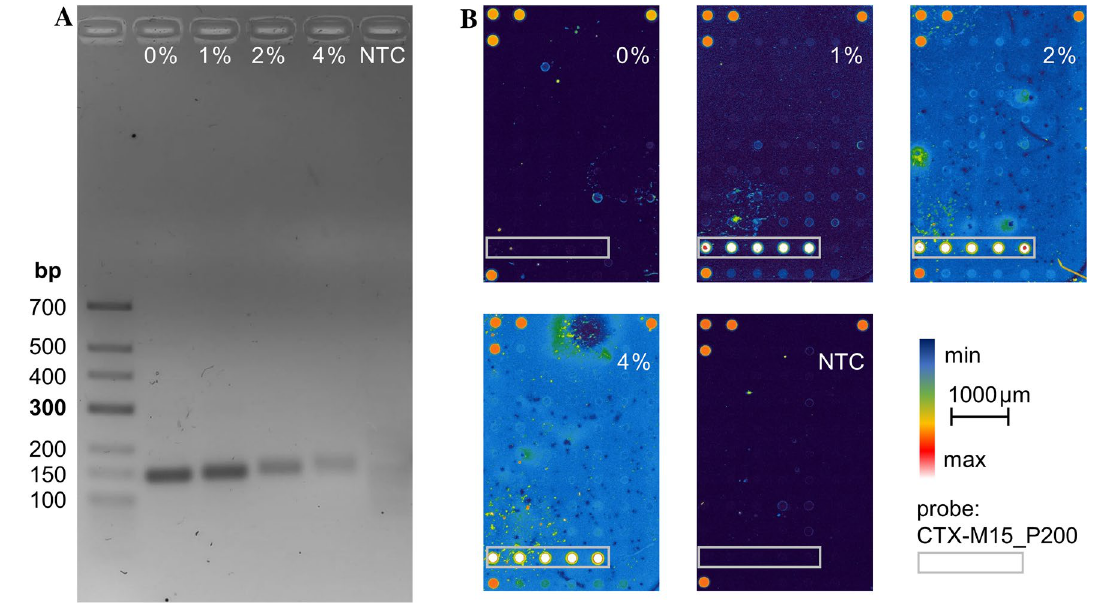
Figure 2. Determination of the suitable Cy5-dUTP amount. 40 min RPA (38 °C) was performed using the resistance gene bla CTX-M15 in E. coli genomic DNA samples as target. ( A ) Gel electrophoresis with purified amplicons after RPA with different Cy5-dUTP amounts compared to the unlabelled dTTP. (NTC: no template control). ( B ) Hybridization and microarray detection of the RPA products shown in ( A ). (grey box indicating the position of the bla CTX-M15 specific probe; pictures are false colour displayed, NTC: no template control; scan power 60% PMT gain 530, five dots in the three corners indicating spotting